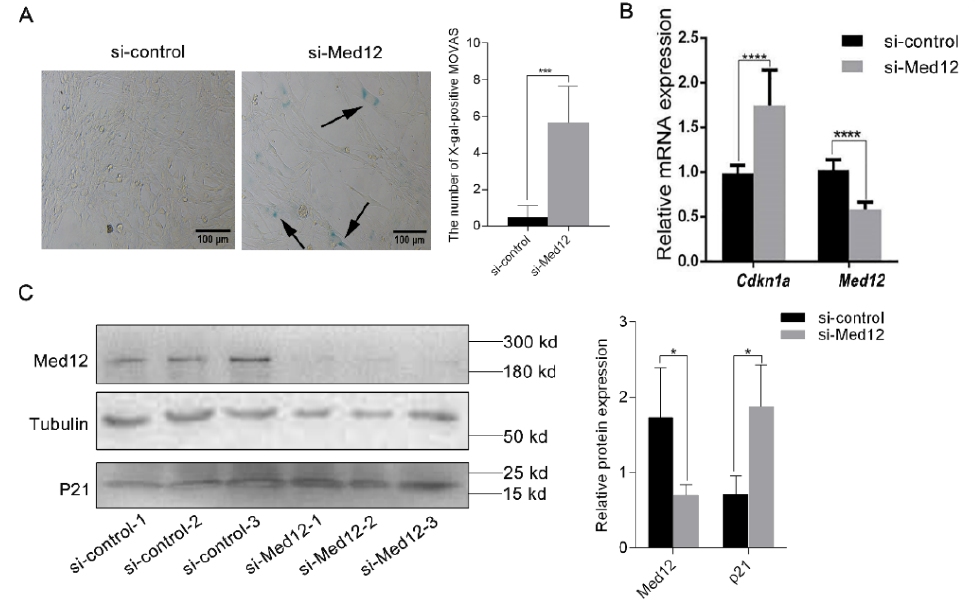
Figure 3. The decreased expression of Med12 promoted the senescence of MOVAS. MOVAS were transfected with si-control or si-Med12 for 72 h. ( A ) Senescent cells were stained with blue by β -galactosidase staining kit as shown by the arrow, and the number of positive cells was quantitatively analyzed. ( B ) The expressions of Med12 and Cdkn1a were detected by RT-PCR. ( C ) The expressions of Med12 and P21 were detected by Western blot. The experiment was repeated at least three times. Data are expressed as mean ± SD. Statistical analyses, unpaired t -test. * p < 0.05; *** p < 0.001; **** p < 0.0001.